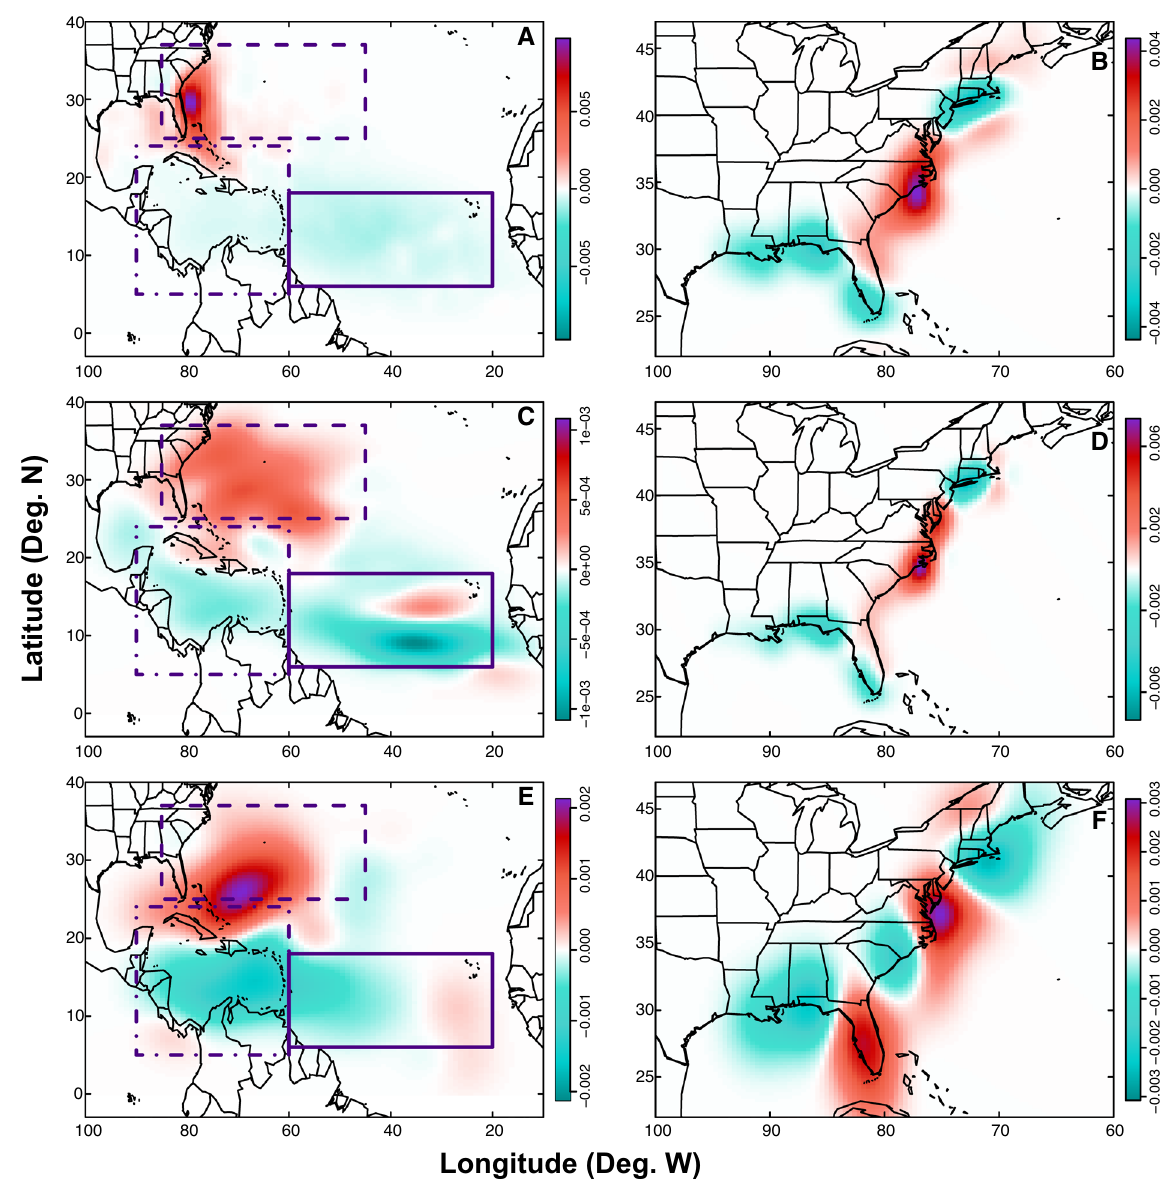
Figure 2. Density difference maps of TC genesis ( A , C , E ) and landfall locations ( B , D , F ) during different parts of the season. Maps show the density differences of TC genesis points ( A , C , E ) and TC first landfall points ( B , D , F ). Density differences are shown for the future minus pre-industrial early season ( A , B ); future minus pre-industrial peak season ( C , D ), and future minus pre-industrial late season ( E , F ). Rectangles ( A , C , E ) are as in Fig. 1. Note that in order to clearly show all results, colorbars are not uniform across maps. Units for the colorbars are TC points per grid cell, where each map has 100 grid cells in both the latitudinal and longitudinal (Figs. 6C,D, S1). In the pre-industrial era, 9.85% of SE US genesis occurs in the early season, 89.97% in the peak season, and 0.18% in the late season. By the future era, the amounts of early and late season genesis increase to 15.12% and 0.48% respectively, while the amount of peak season genesis decreases to 84.40%. This variation results in a broader temporal distribution for TC genesis in the future, with a decreased density during peak months, and increased density during the early- and late-season months. Vertical wind shear and relative humidity anomalies at time of TC genesis. Shifts in TC genesis patterns are accompanied by shifts in vertical wind shear and atmospheric relative humidity. A comparison of shear and relative humidity values that provide a snapshot in time of the environment in which each TC forms allows us to examine how these variables may change for TCs forming across regions in the future relative to a 1980–2000 baseline (see “Methods”).